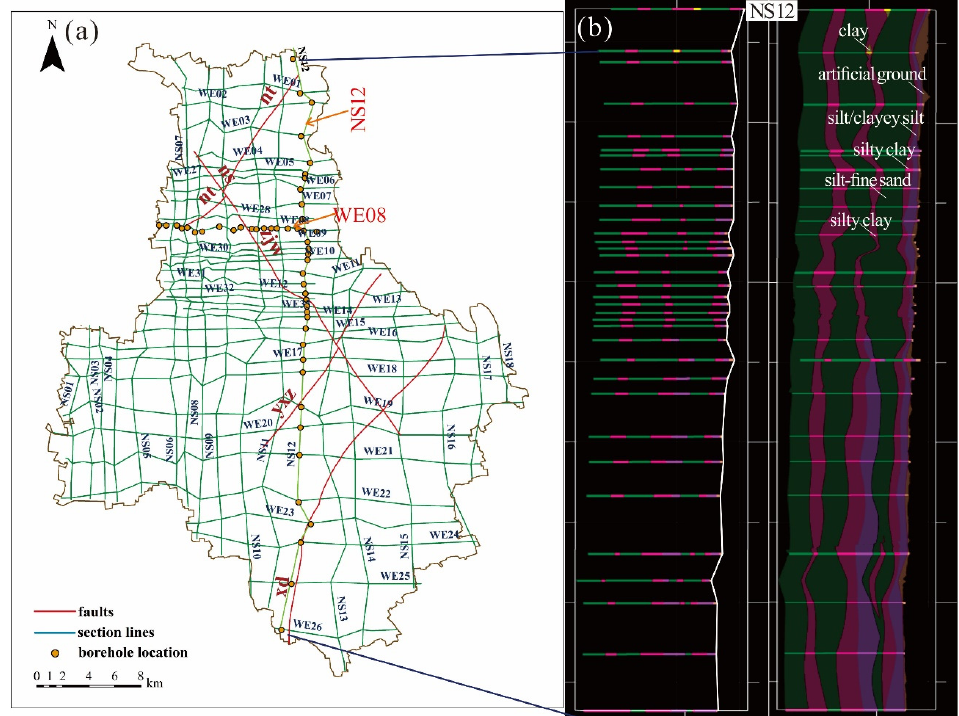
Figure 5. Cross-section lines in the study area: ( a ) section lines and active faults (depth of upper breakpoint <50 m). Five buried faults including the Nanyuan-Tongxian (nt) fault, Nankou-Sunhe (ns) fault, Yaoxinzhuang (yxz) fault, Zhangjiawan (zjw) fault, and Xiadian (xd) fault; ( b ) geological units developed along NS12 cross-section.